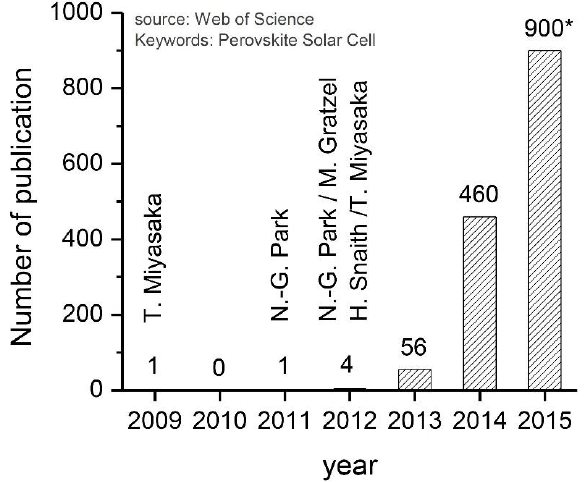
Figure 2. The number of papers published with a topic pertaining to perovskite solar cell.